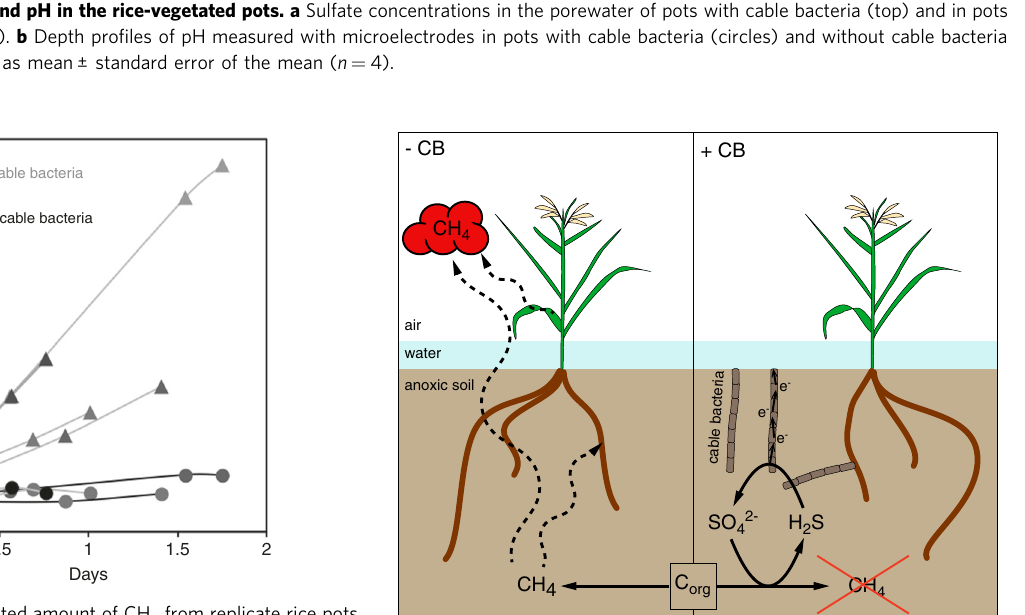
Fig. 3 CH 4 emissions. The emitted amount of CH 4 from replicate rice pots with cable bacteria (circles) and without cable bacteria (triangles) normalized to the surface area of the pots as a function of time.